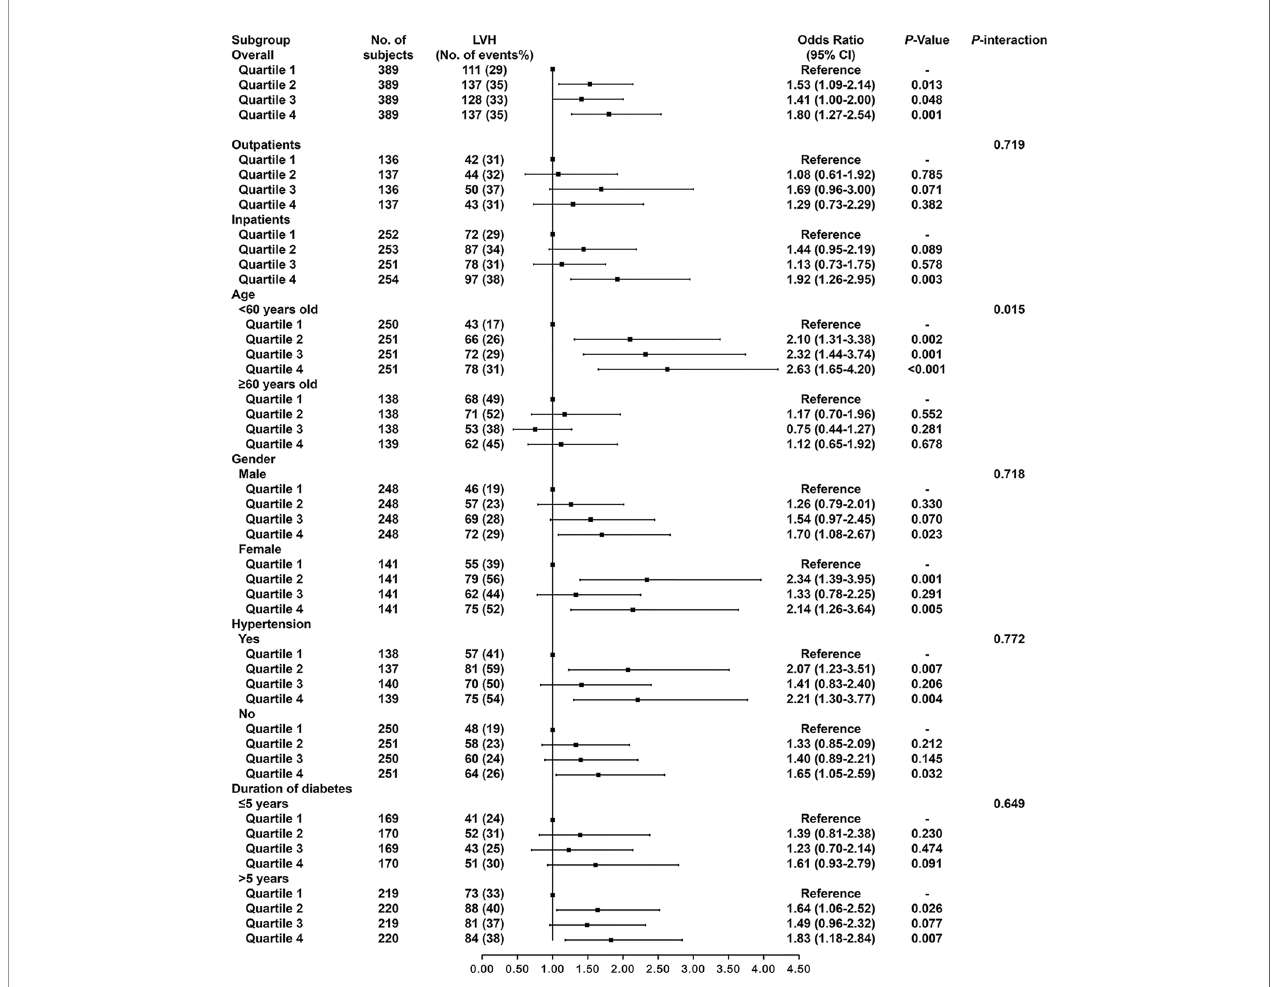
FIGURE 1 | Odds ratios of LVH according to urinary sodium excretion levels in different subgroups. Adjusted for age, gender, smoking, alcohol consumption, hypertension, use of RAS blocking agents, use of diuretics, history of hyperlipidemia, use of statin, HbA1c and use of antidiabetic medication.